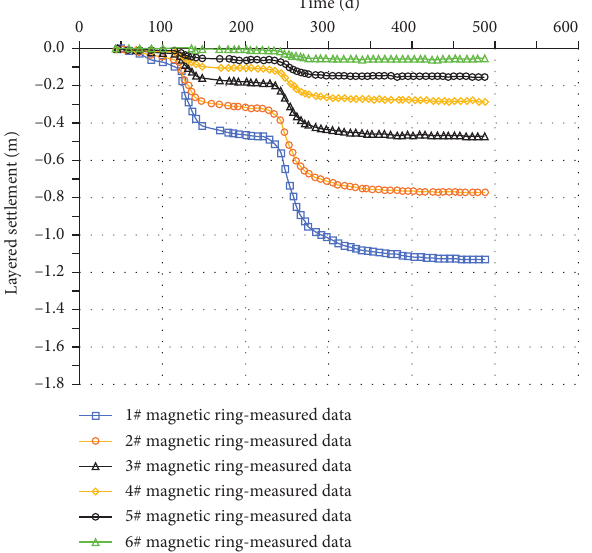
Figure 9: Comparison of the monitoring values and the numerical calculation results of the layered settlement.